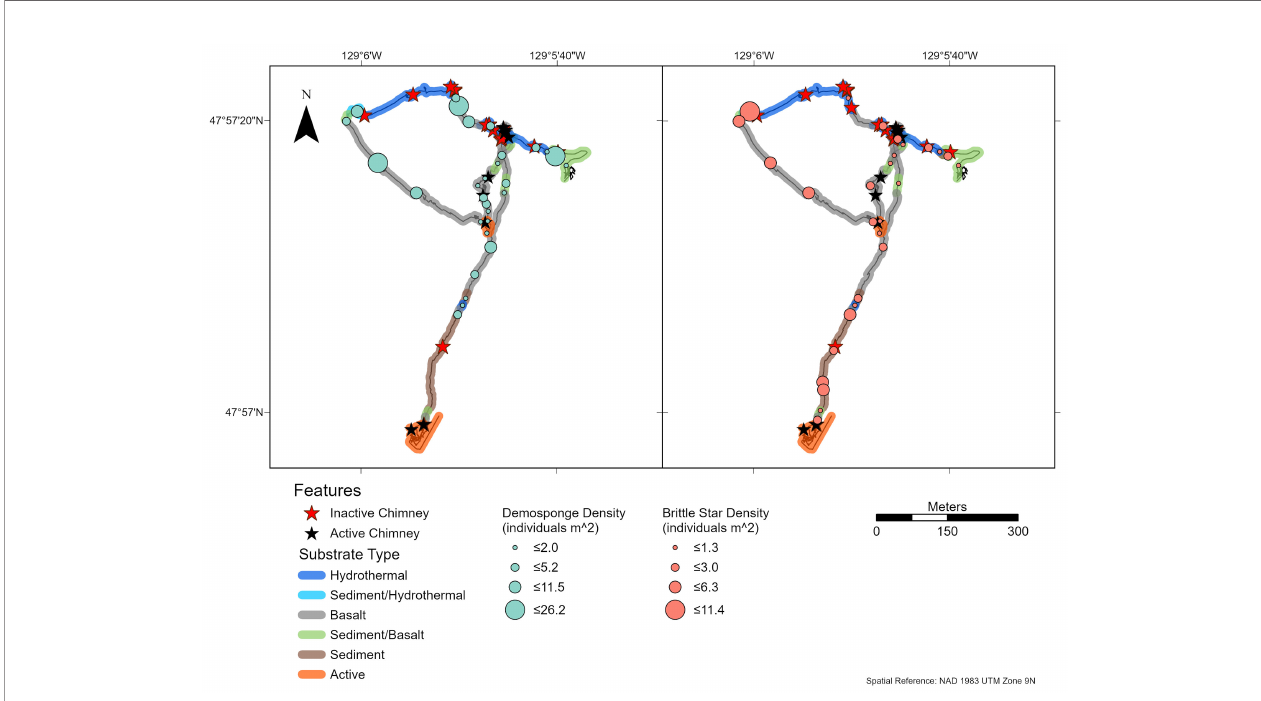
FIGURE 8 | Density of brittle stars (Ophiuroidea spp.) and demosponges (Demospongiae sp. 1) on dive R1940, at the Endeavour Segment of the Juan de Fuca Ridge sampled in August 2016. Each symbol indicates density in an image captured at that location. These two morphotaxa were identi fi ed as the numerically dominant faunal groups (present in ≥ 25% of images) (n = 28, 29 for Ophiuroidea spp. and Demospongiae sp.1, respectively). “ Hydrothermal ” substrate refers to inactive substrate that is hydrothermally derived.